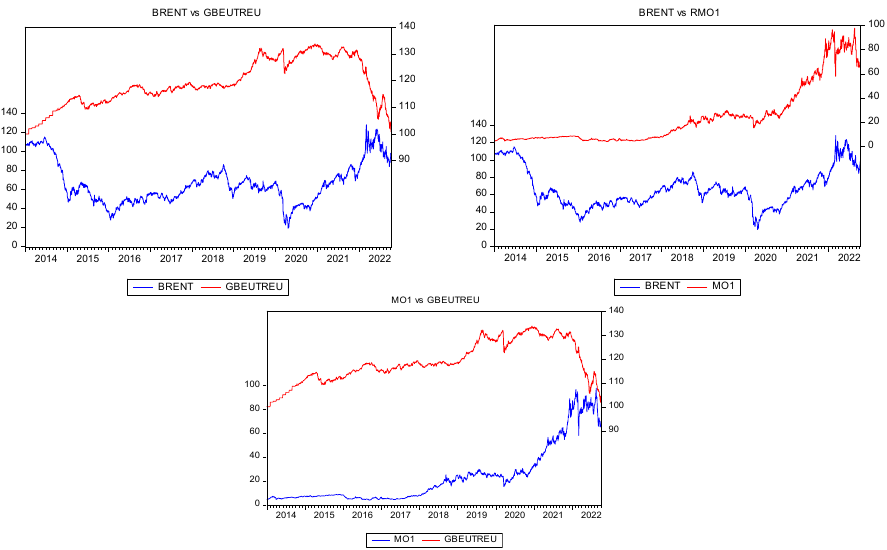
Figure 4. Daily prices and returns of Brent oil prices (RBRENT), Green Bond Index (RGBEUTREU), and CO 2 futures’ returns (RMO1). Source: Author’s own research using data from Bloomberg. Table 2. Summary statistics of daily